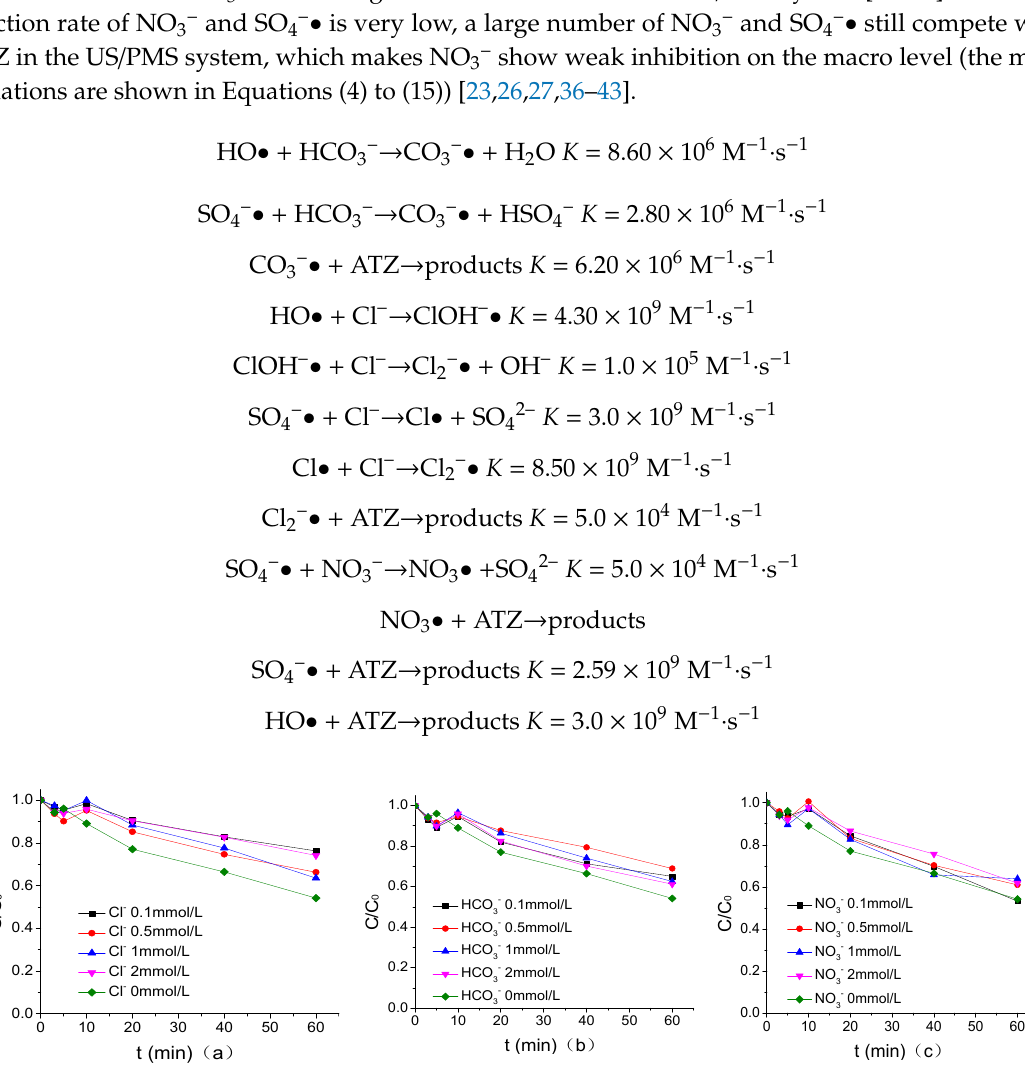
Figure 7. ( a ) The effect of Cl - on the degradation of ATZ by US/PMS in PB at pH 7. ( b ) The effect of HCO 3- on the degradation of ATZ by US/PMS in PB at pH 7. ( c ) The effect of NO 3- on the degradation of ATZ by US/PMS in PB at pH 7. The initial concentration C 0 = 1.25 μ mol/L.